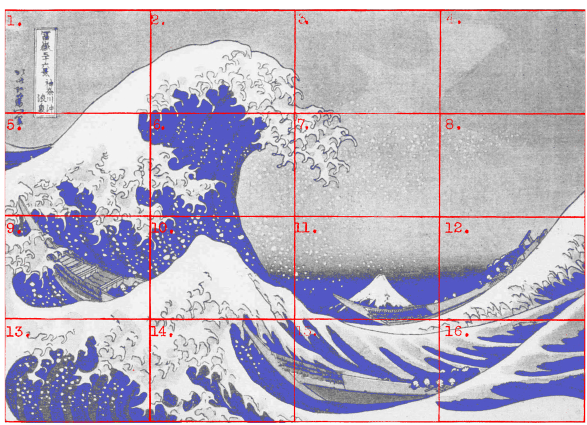
Figure 5. A grid of 16 rectangles superimposed on Hokusai’s The Wave . (Adapted from Picture 13 and Plate XVI in Buswell,